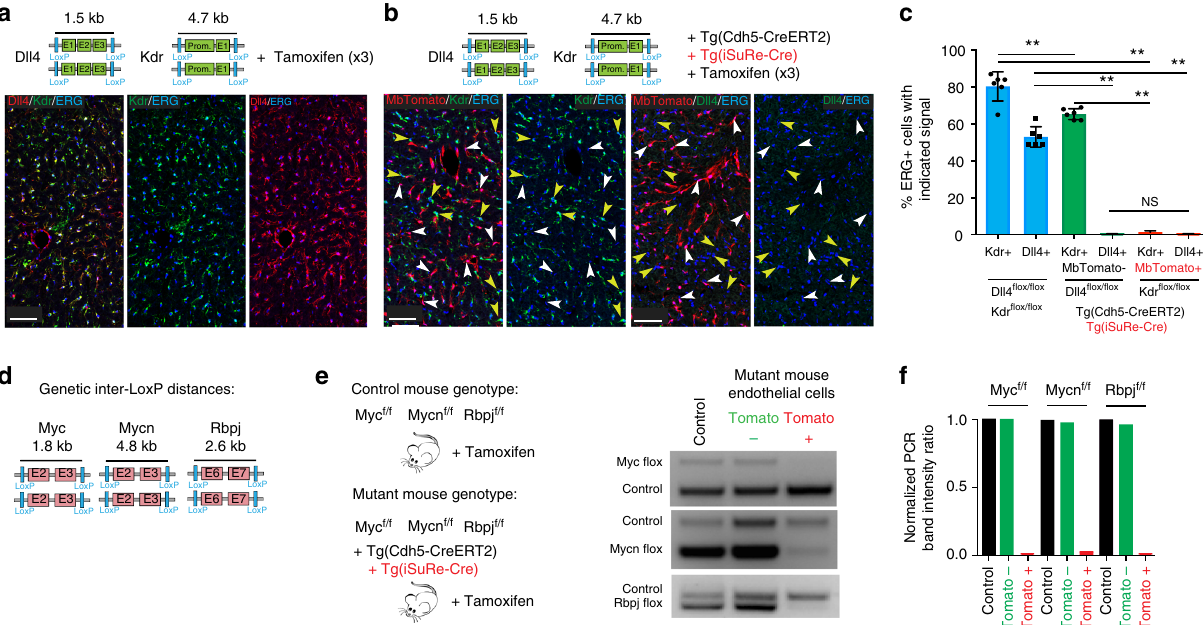
Fig. 5 The Tg(iSuRe-Cre) allele enables multiple gene deletions in single cells or tissues. a The schemes illustrate the Dll4 and Kdr fl oxed alleles, showing inter-LoxP-site genetic distance, which is signi fi cantly larger in the Kdr allele. All four alleles must be deleted to achieve full dual gene loss-of-function. Kdr and Dll4 proteins are expressed in most liver ECs (ERG + , nuclei) of Dll4 fl ox/ fl ox /Kdr fl ox/ fl ox animals injected with tamoxifen on 3 consecutive days. b Adult mice carrying in addition the Tg ( Cdh5-CreERT2) and Tg(iSuRe-Cre) alleles and treated with the same high-dose tamoxifen for 3 consecutive days show very pronounced deletion of Dll4 , but not Kdr , in liver MbTomato - /ERG + ECs (yellow arrowheads). However, MbTomato + cells (white arrowheads) have complete deletion of both genes. c Quanti fi cation of the immunostaining signals for ERG, Dll4, Kdr, and MbTomato in large liver sections of the indicated animals. d Illustration of the Myc , Mycn , and Rbpj- fl oxed alleles showing the genetic distances between the LoxP sites. e Genotypes of control and mutant adult mice injected once with 1 mg of tamoxifen and used for gene-deletion quanti fi cation by PCR. The control PCR band provides a DNA input quantitative control for the PCR, since it corresponds to a wild-type genomic sequence, present in all DNA samples (see supplementary table 2 for primer sequences). Animals containing the Tg ( Cdh5-CreERT2) and Tg(iSuRe-Cre) alleles have deletion of the six fl oxed alleles only in FACS-sorted MbTomato + cells, as detected by semi-quantitative competitive PCR. Weak Mycn and Rbpj - fl oxed bands in the MbTomato + sample PCR may result from incomplete gene- deletion or contamination of this sample with MbTomato-negative cells, or their DNA, during the FACS protocol. f Image J quanti fi cation of the relative intensity of the fl oxed and control PCR gel bands shown in e , providing an estimate of the degree of the indicated fl oxed gene deletion. Scale Bars 65 μ m. Error bars indicate StDev. ** p < 0.001. NS nonsigni fi cant. One-way ANOVA with Tukey ’ s post hoc test. Source data are provided as a Source Data fi